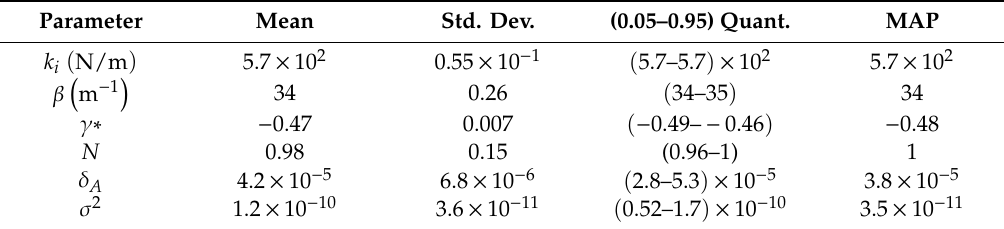
Table 6. Marginal posterior distribution of the BWBN model parameters for the case study.